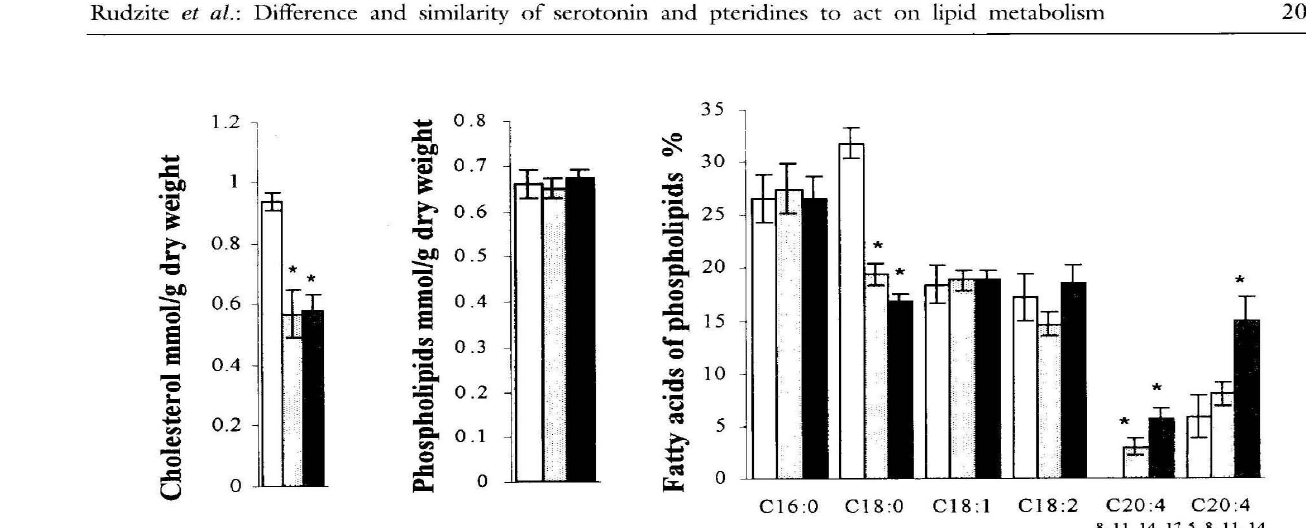
Figure 2. Concentration (mean ± S.D.) of cholesterol and phospholipids, as well as fatty acid content (in percent: mean ±S.D.) of phospholipids in controls (open bars) and in samples with 5 pmoljg wet weight (dotted bars) and 30 pmolj g wet weight (hatched bars) S,6,7,8-tetrahydrobiopterin. Samples of rat liver tissue homogenates were used to test for phospholipid biosynthesis in vitro. Incubation medium: Krebs-Ringer-phosphate buffer, containing 0.3% albumin (pH= 7.4), fatty acid mixture and glycerol. Samples were incubated twice for 4 h at 37°C. *The changes are statistically sig nificant (p < O.OS-p < 0.001).